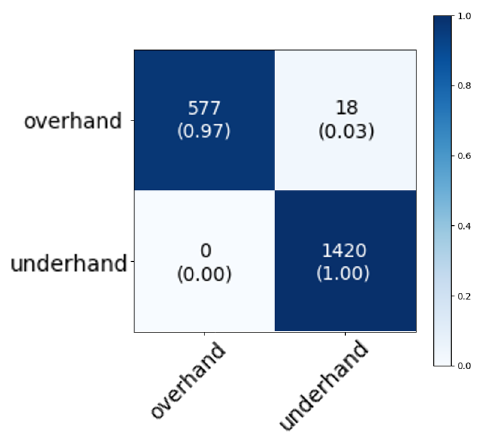
Figure 7. Confusion matrix for distinguishing overhand and underhand strokes. We notice that the overhand and underhand strokes are correctly classified with an average accuracy of